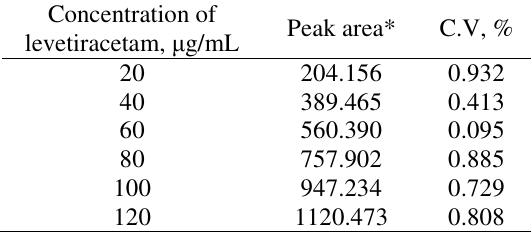
Table 1. Calibration of HPLC method for the estimation of levetiracetam.